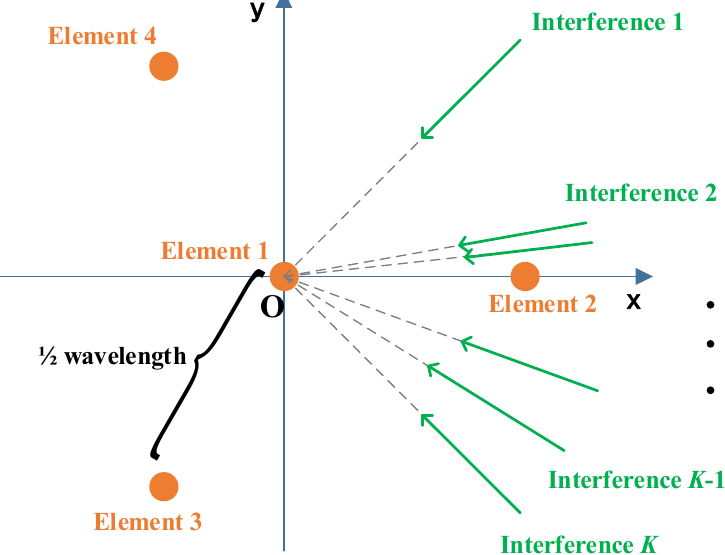
Figure 4. The selection of initial iteration